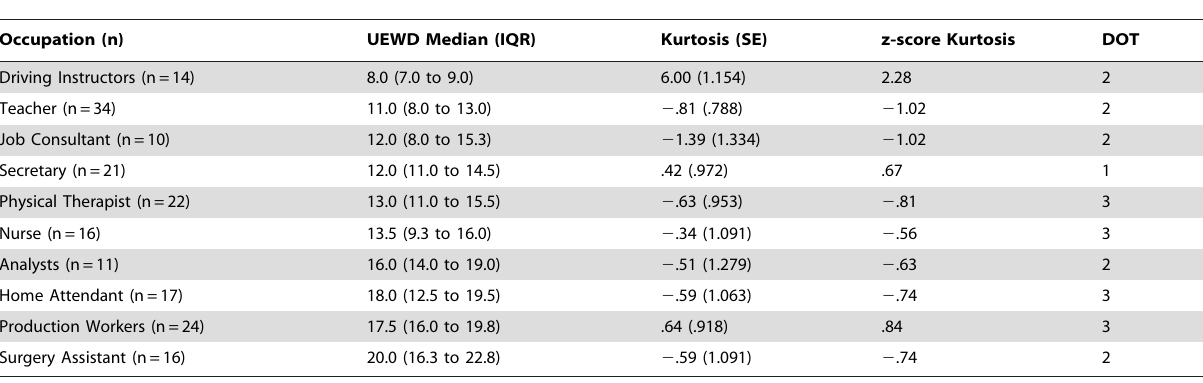
Table 1. Upper Extremity Work Demands-scores of occupational groups.